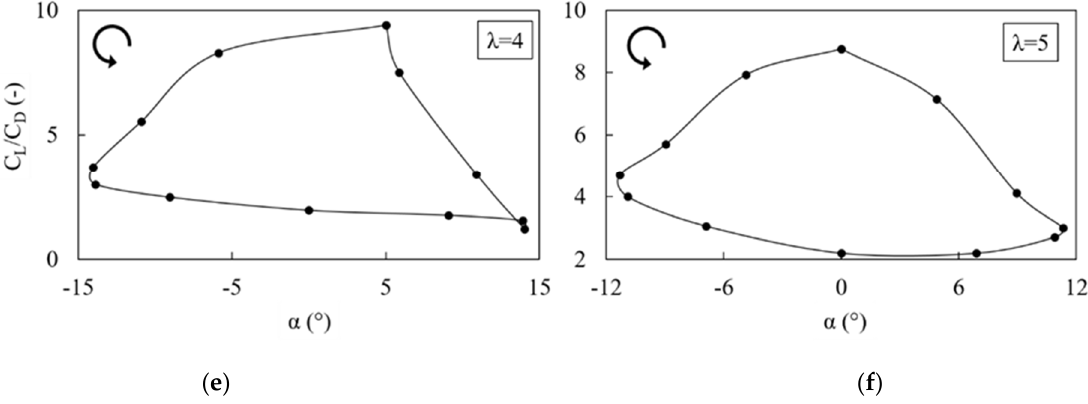
Figure 8. C L /C D for single blade for one turbine blade rotation: ( a ) TSR = 1, ( b ) TSR = 2, ( c ) TSR = 3, ( d ) TSR = 3.5, ( e ) TSR = 4, ( f ) TSR = 5.